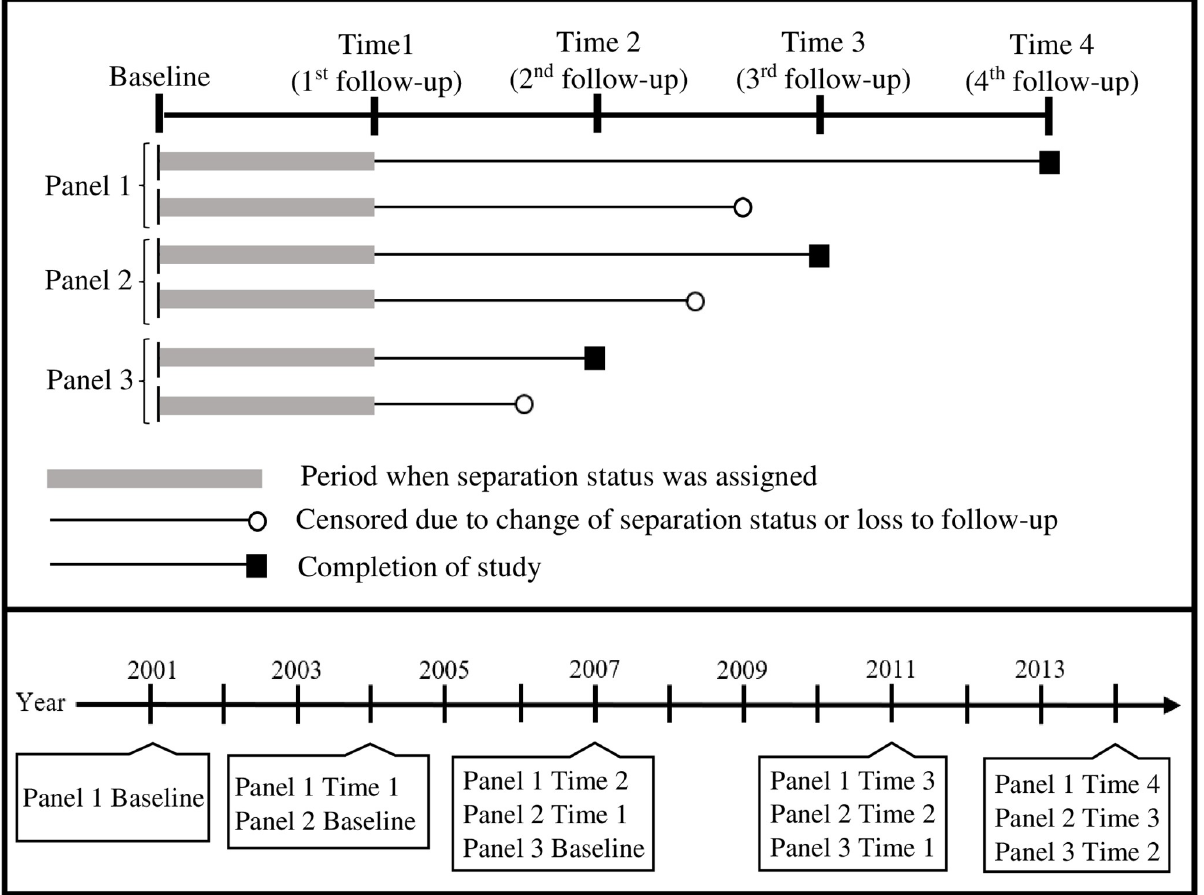
Fig 1. Study design diagram by panel and time point as well as by panel and calendar